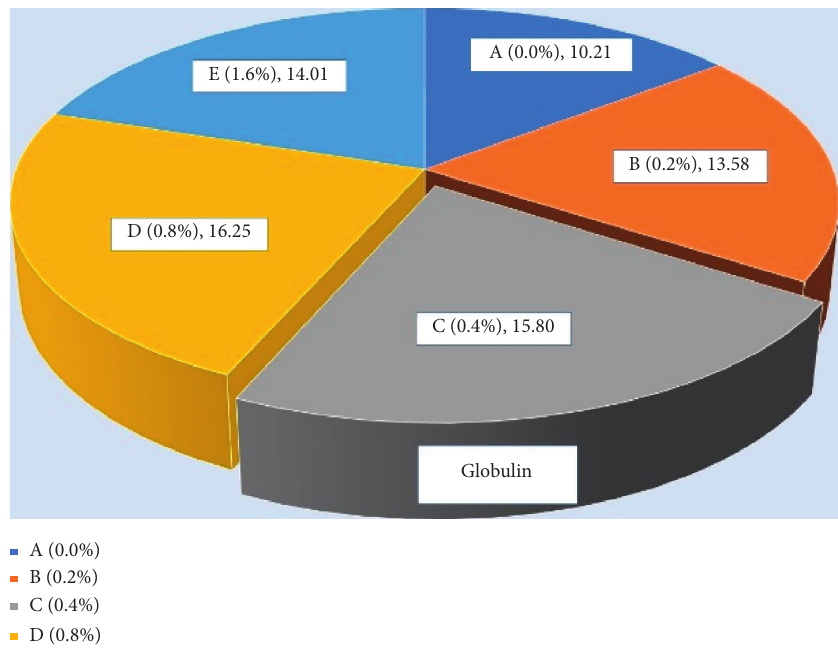
Figure 10: Cyprinus carpio fed varied doses of Aloe vera and globulin contents from liver tissues were studied after 90 days of feeding trial.